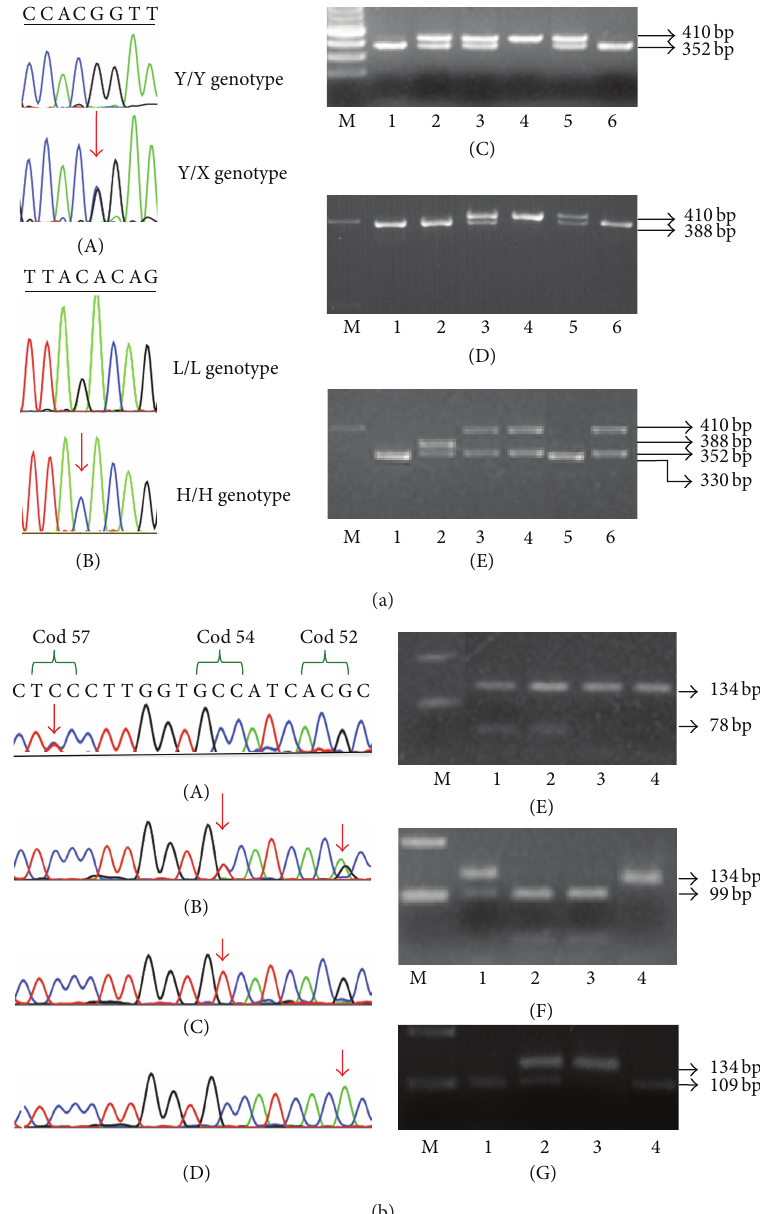
Figure 1: The detected polymorphisms of MBL2 gene in Greek neonates. (a) Detection of promoter polymorphisms. Sequencing analyses indicating the presence of (A) the X/Y (-221G > C) and (B) the L/H (-550G > C) polymorphisms. (C) Representative digestion showing